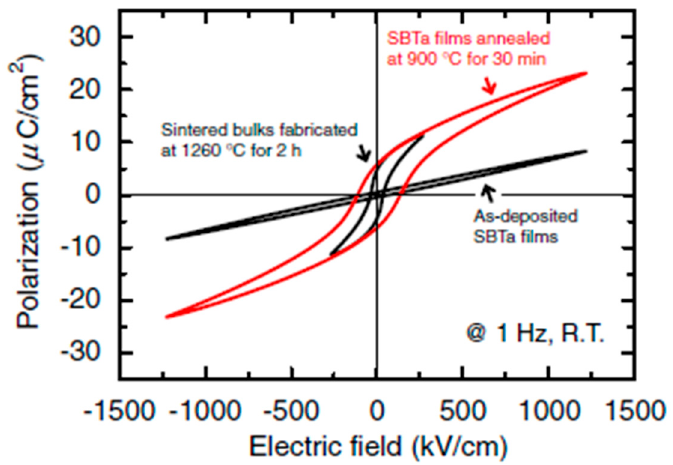
Figure 18. P - E curves of AD films deposited on Pt / Ti / YSZ substrates and sintered bulk [49]. © Copyright 2012, Jpn. J. Appl. Phys. Lett.